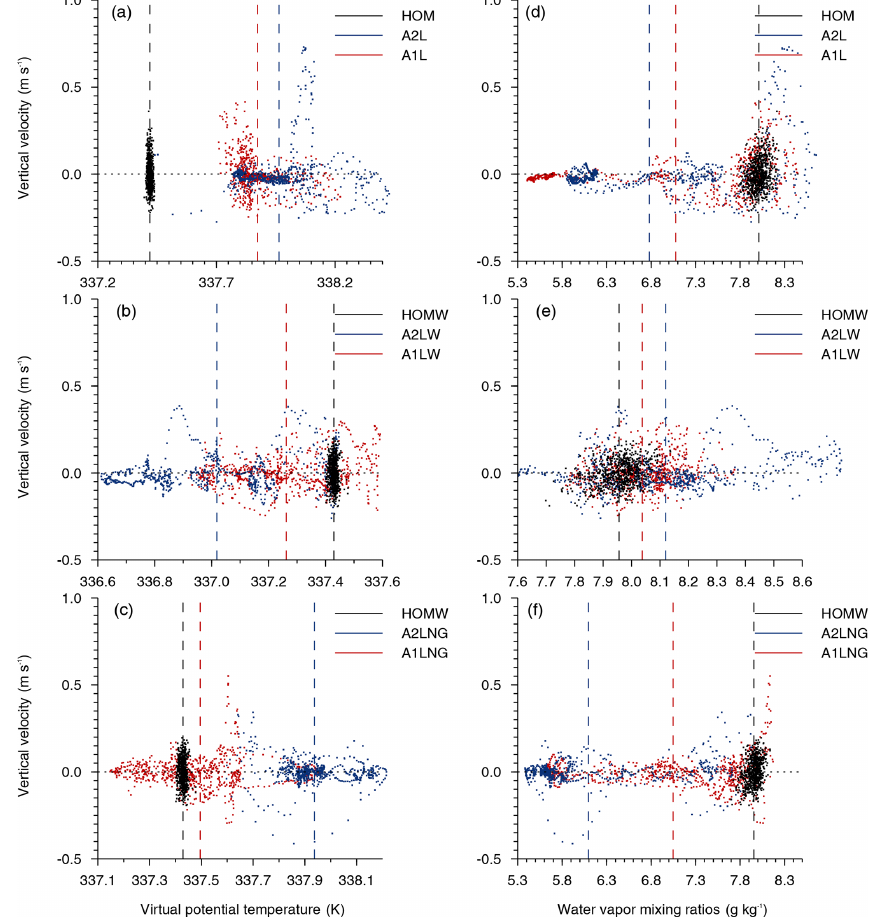
Figure 13. The joint vertical velocities, virtual potential temperatures (a–c) , and water vapor mixing ratios (d–f) at the top of the CBL for the homogeneous runs (black dot) and heterogeneous runs (red for one lake and blue for two lakes). The black dotted lines represent the mean vertical velocity; the black, red, and blue dashed lines show the mean virtual potential temperatures and water vapor mixing ratios for the homogeneous run, one-lake run, and two-lake run,